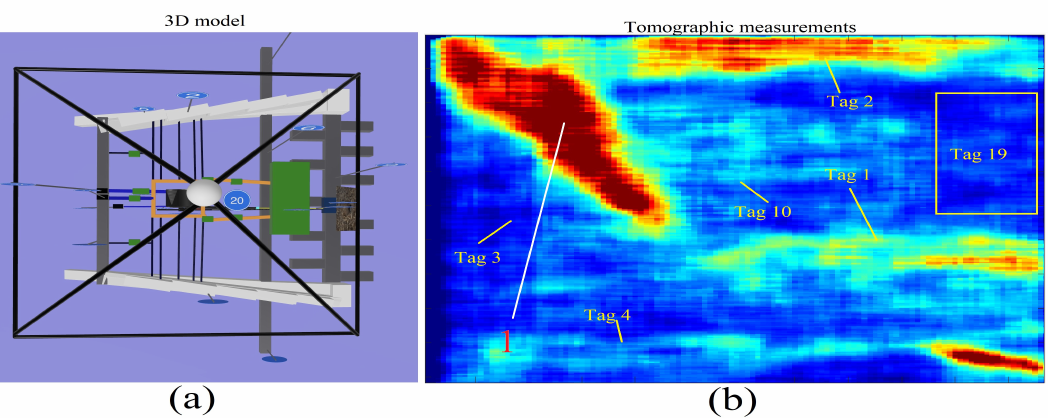
Figure 56. Tags association from tomography to 3D model. ( a ): Three-dimensional (3D) model of Khnum-Khufu. ( b ): Tomographic reconstruction (magnitude).